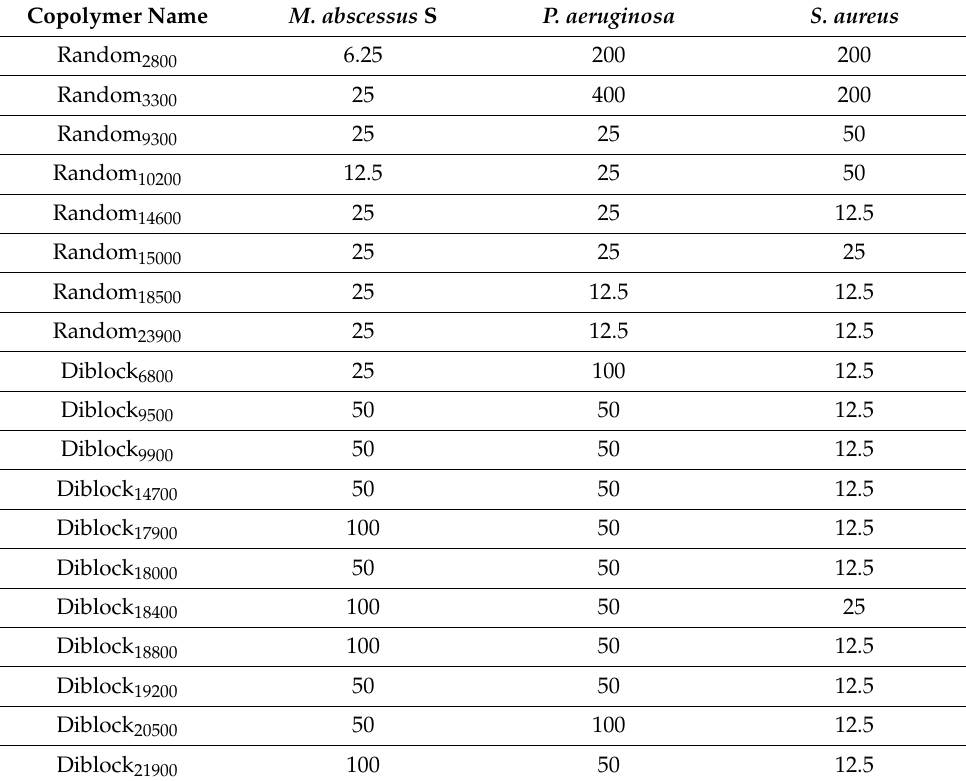
Table 2. Evaluation of the antimicrobial activity of the Random and Diblock copolymers. MIC of Random and Diblock copolymers were measured as described in Materials and Methods section and are expressed in µ g/mL (n ≥ 3). Copolymer Name Random